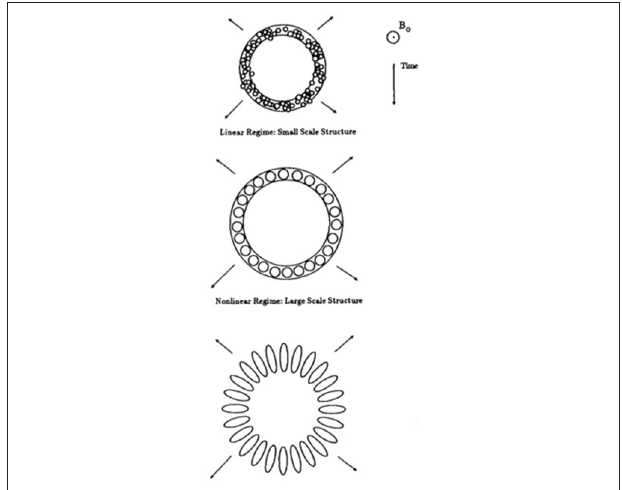
FIGURE 6 | Pictorial representation of the understanding of striation formation and development from Figure 17 in Huba et al. (1990), showing progression from small random waves generated in the expanding shell at early times, coalescence to larger wavelengths and then expansion of the longer wavelengths modes beyond the surface of the shell at later times. The figure is reproduced with permission from The American Institute of Physics.